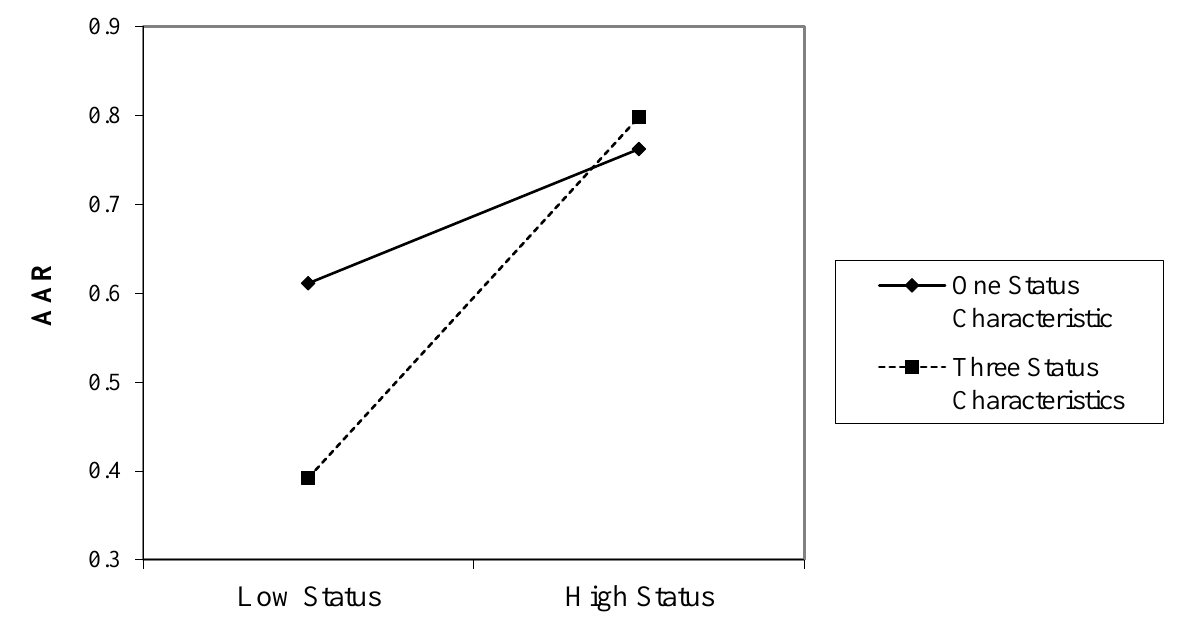
Figure 1: Simple slopes plot with binary interaction between relative status position and magnitude of manipulated status